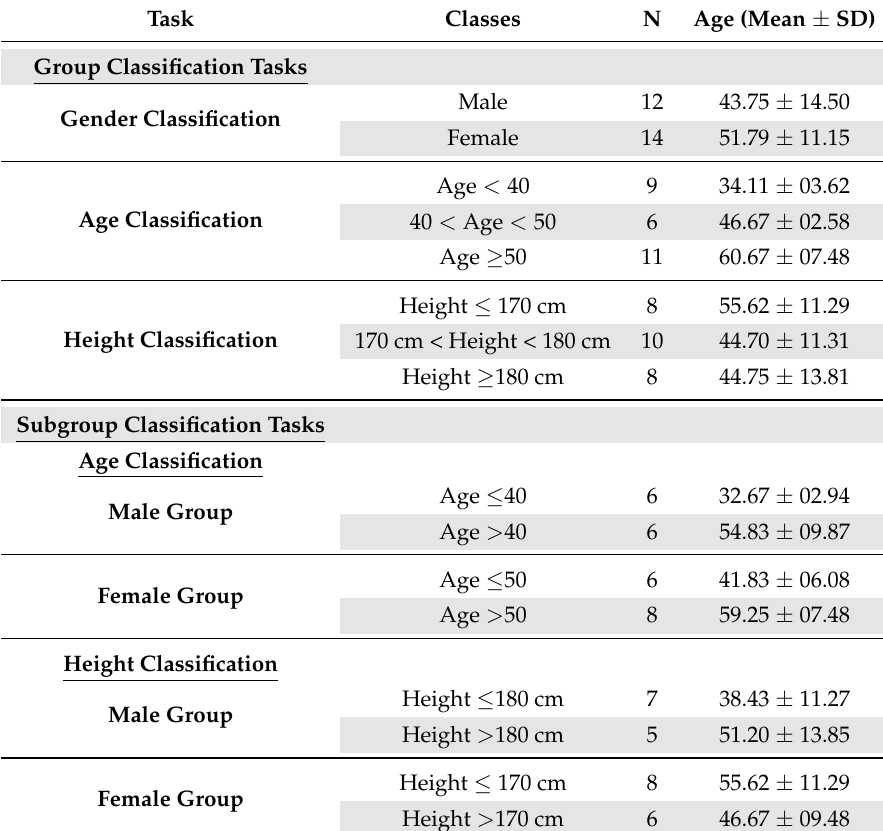
Table 5. Characteristics of the population within different group and subgroup classification tasks.